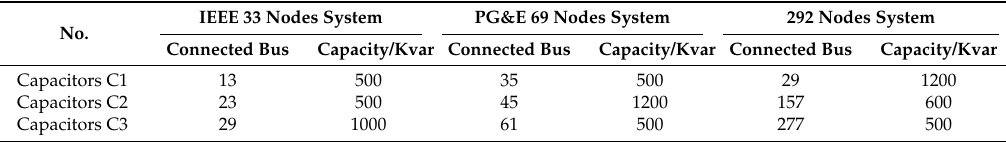
Table 5. The configuration of capacitors in three different scale distribution